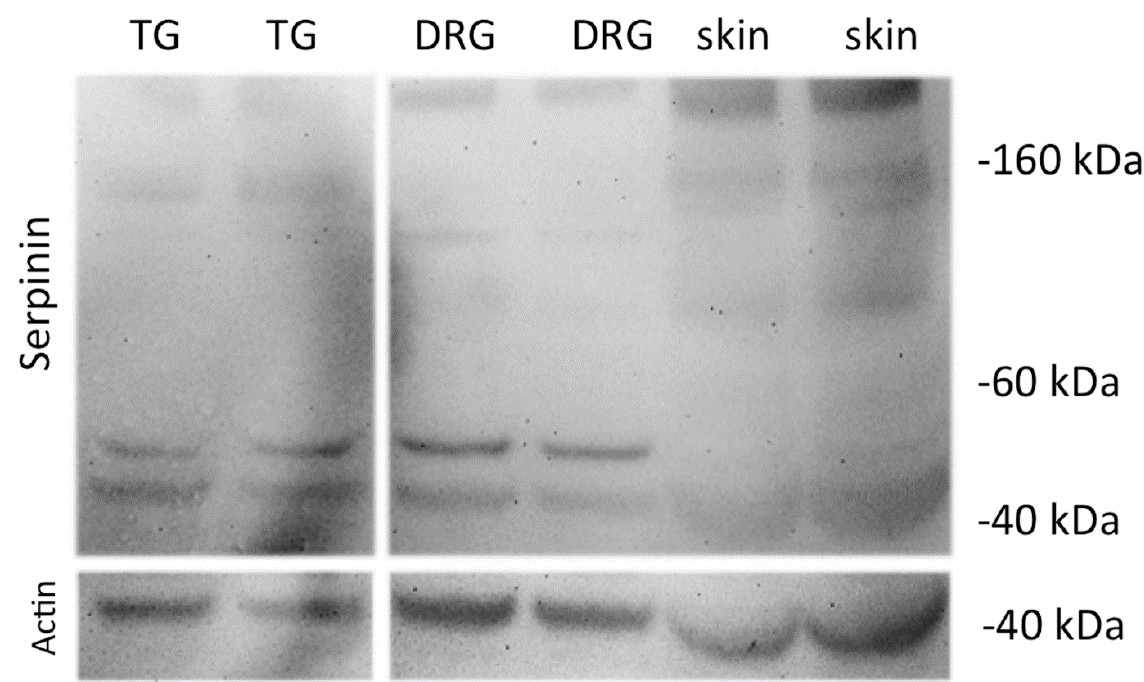
Figure 1. Western blot analysis of serpinin immunoreactivities in rat TG, rat DRG and rat skin. Note the presence of two strong bands at 40 kDa and 50 kDa in both TG and DRG representing two larger molecular forms containing the sequence of serpinin, whereas no bands were observed in the skin. Actin represents an internal standard at 42 kDa as a control.